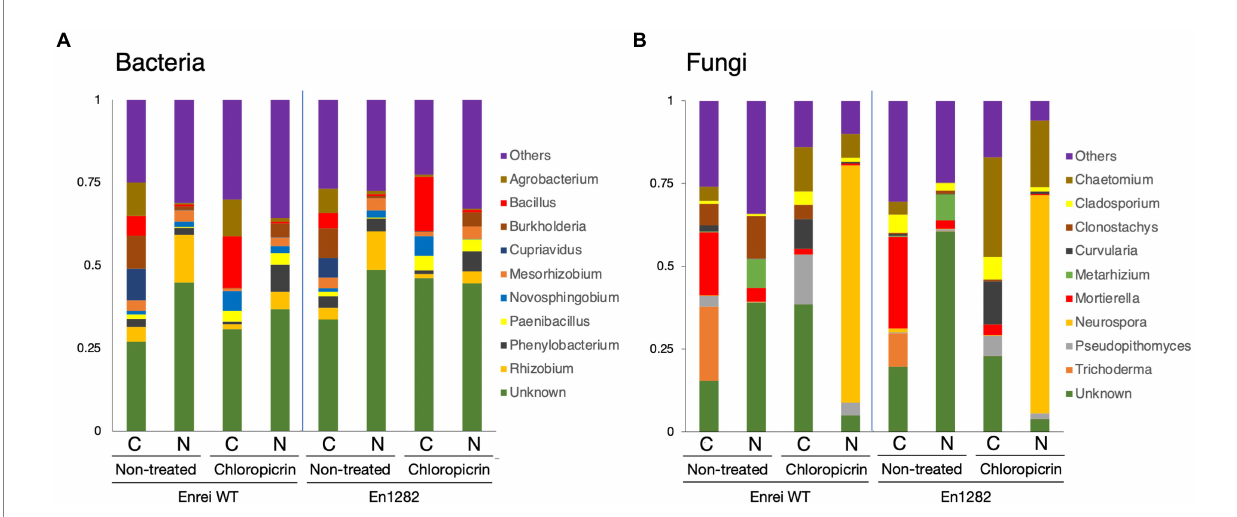
FIGURE 3 Taxonomic composition of microbial communities inhabiting the rhizosphere of soybean grown in conventional and nature farming soils with and without chloropicrin treatment. The bar graphs represent the relative abundance of bacterial (A) and fungal (B) communities at the genus level. Only taxa with abundance >1% are shown. WT = Enrei cv. C, conventional farming soil, N, nature farming